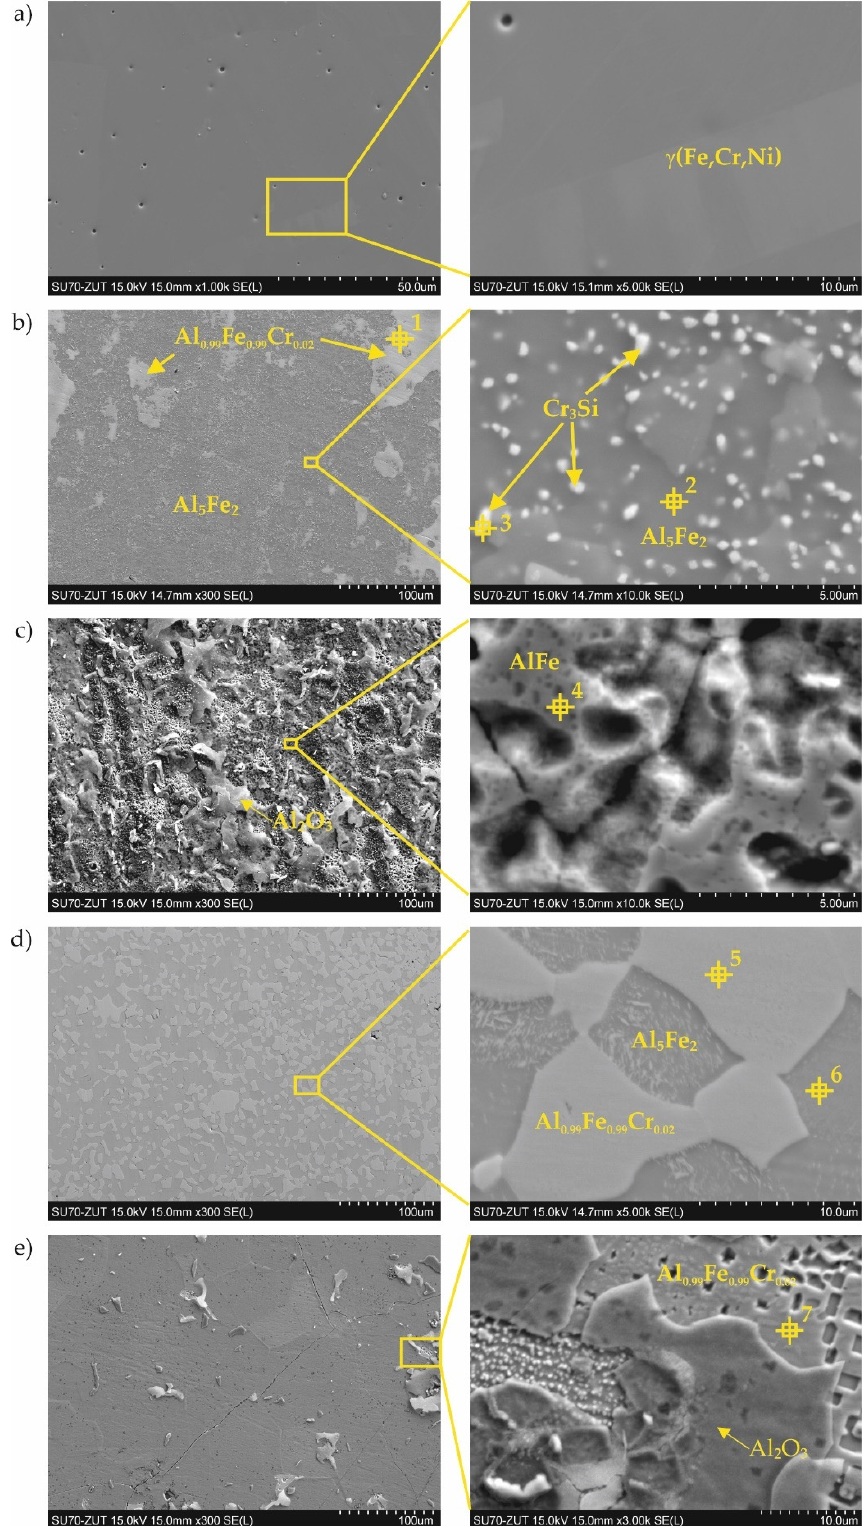
Figure 2. Surface of 1.4541 steel: ( a ) uncoated; ( b ) with coating No. 1 (800 °C, 2 h); ( c ) with coating No. 2 (800 °C, 2 h + oxidation 1000 °C); ( d ) with coating No. 3 (1000 °C, 2 h); ( e ) with coating No. 4 (1000 °C, 2 h + oxidation 1000 °C).